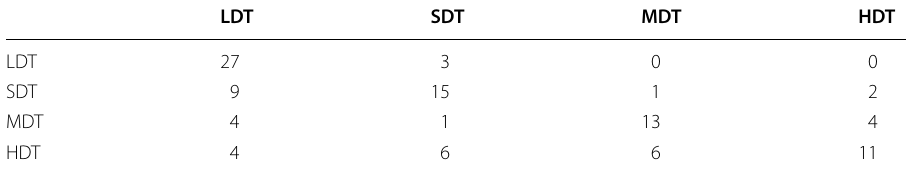
Table 5 Confusion matrix for the Tree Ensemble predictor